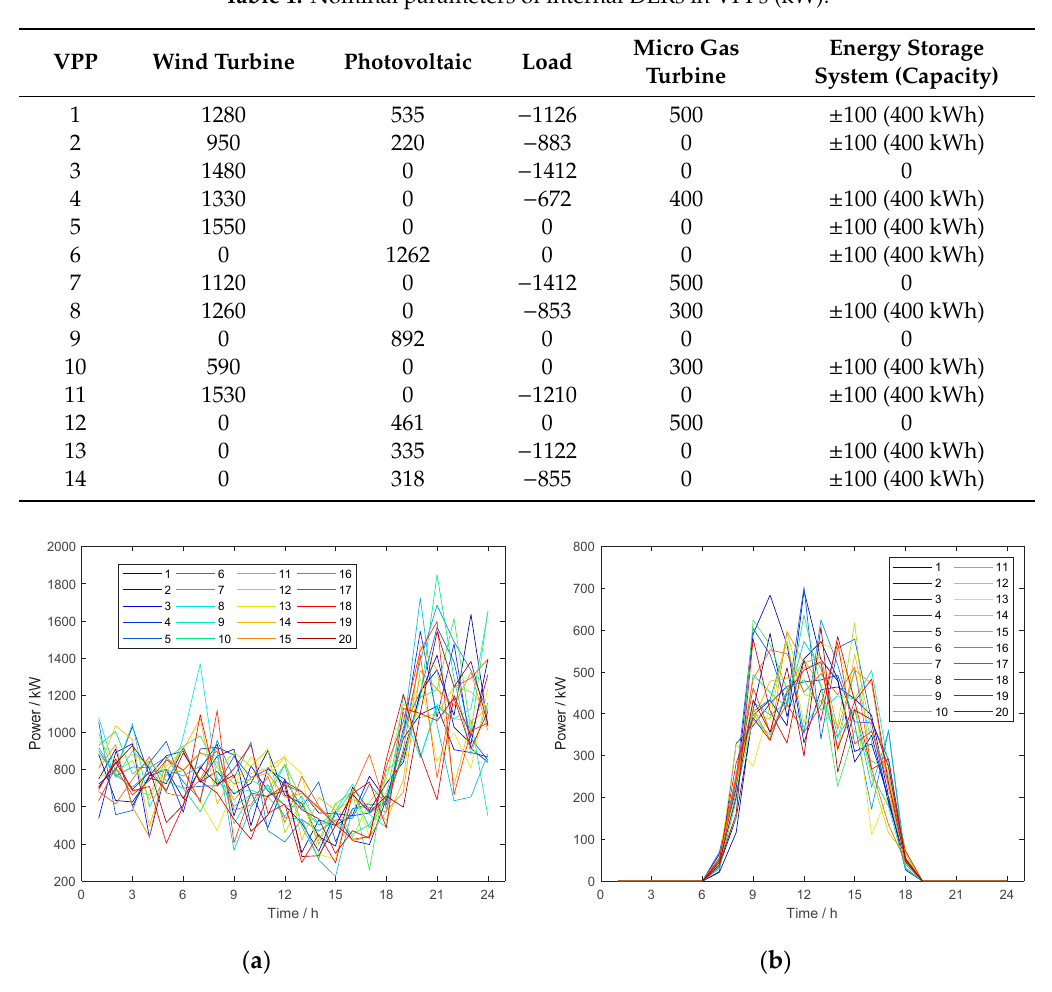
Figure 5. Twenty typical scenarios of wind/photovoltaic power in VPP 1 : ( a ) wind power; ( b ) photovoltaic power.